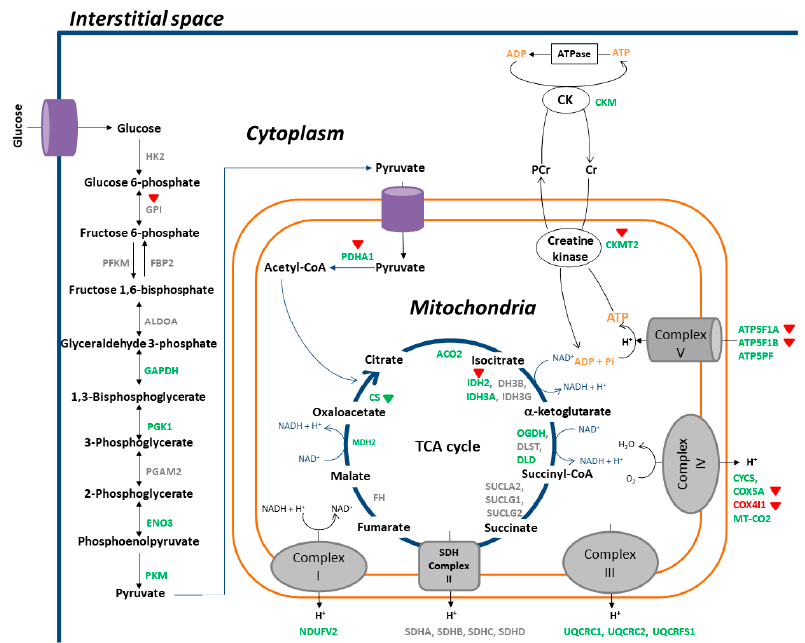
Figure 6. A schematic representation of molecular alterations involved in energy metabolism occurring in gastrocnemius muscles affected by RA and the effects of coriander treatment. Proteins with no significant change or no detection are in gray color. Proteins that were downregulated by RA are in green color, whereas these were upregulated are in red color. Triangles in red color indicate the upregulating effects of coriander, whereas triangles in green color indicate the downregulating effects of coriander.